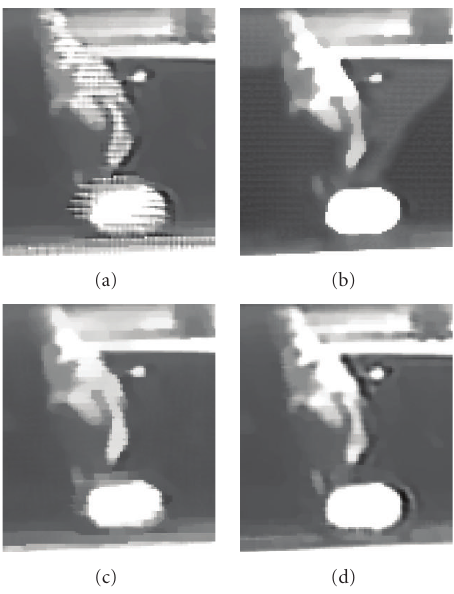
Figure 2: Car sequence: reconstructed HR image using, (a) L 2 - norm-based [1], (b) L 1 -norm-based [2], and (c) and (d) proposed algorithm for Case I and Case II,